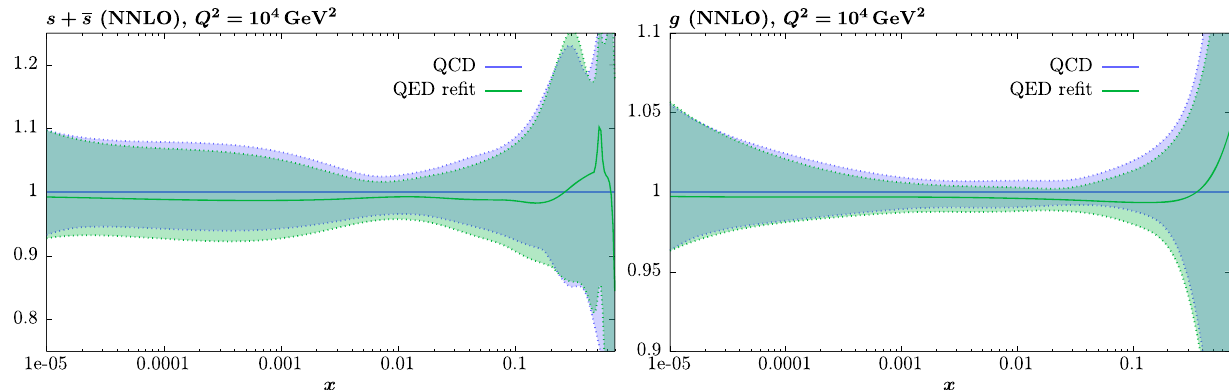
Fig. 4 The ratio of the s + s and g distributions (with uncertainties) at Q 2 = 10 4 GeV 2 , resulting from NNLO fits to the MSHT20 dataset, with QED effects included to that without